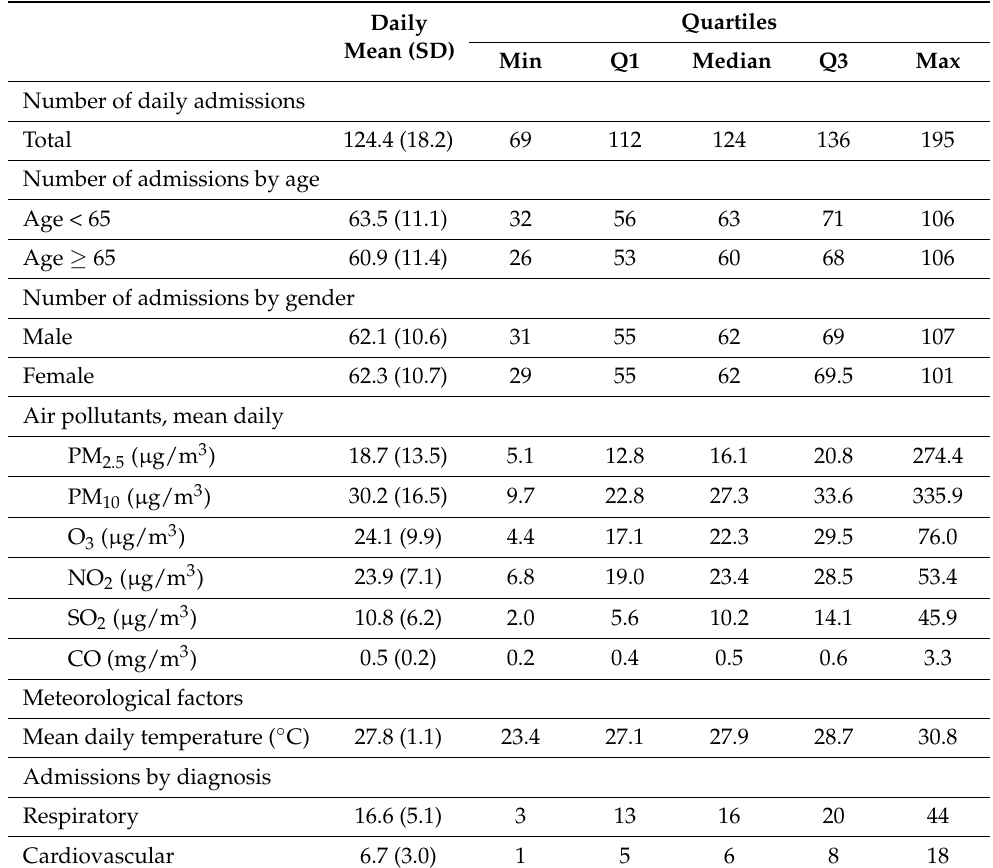
Table 1. Summary of daily measures of emergency hospital admissions and air pollutants, from 2009 to